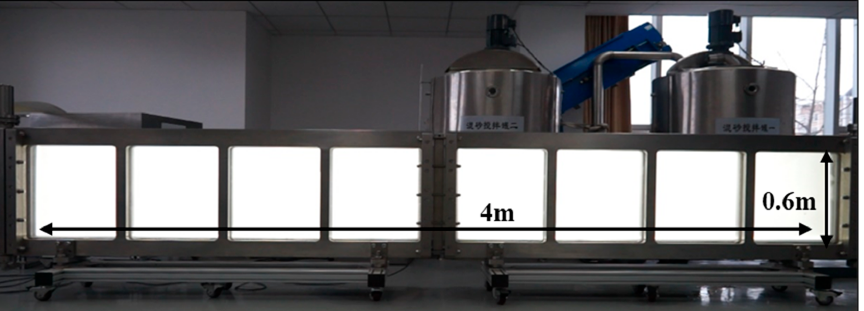
Figure 4. Proppant transport experimental system. Table 1. Parameters set for experiment and simulation.